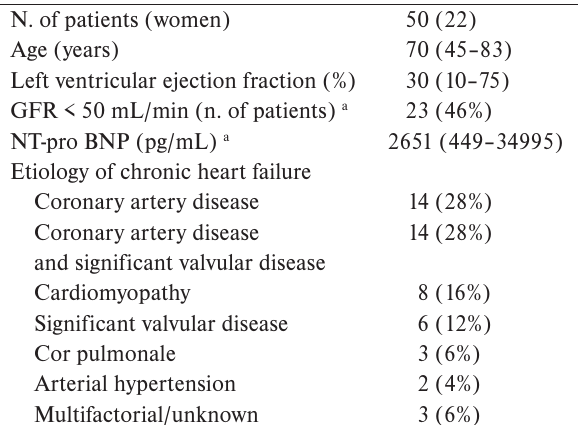
Table 1. Principle characteristics of the study patients.